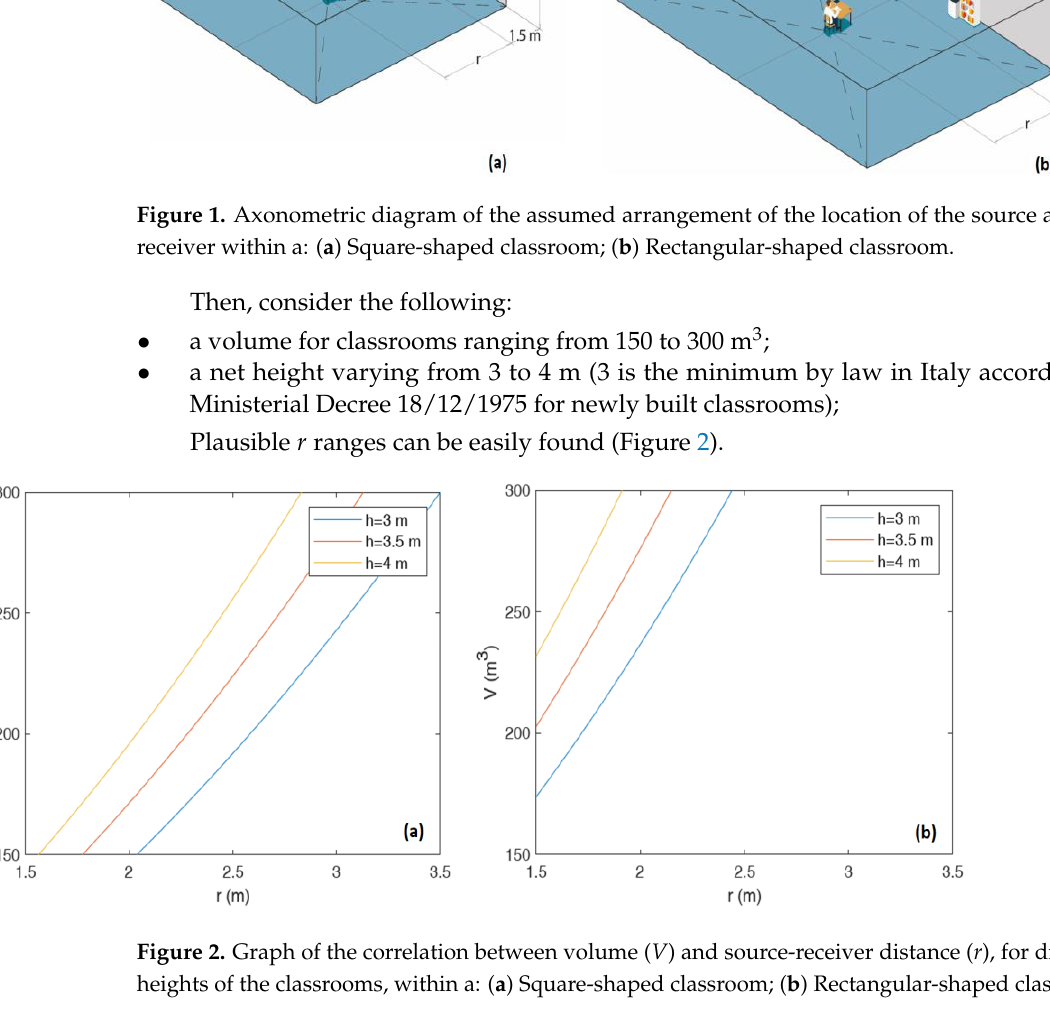
Figure 2. Graph of the correlation between volume ( V ) and source-receiver distance ( r ), for different heights of the classrooms, within a: ( a ) Square-shaped classroom; ( b ) Rectangular-shaped classroom.